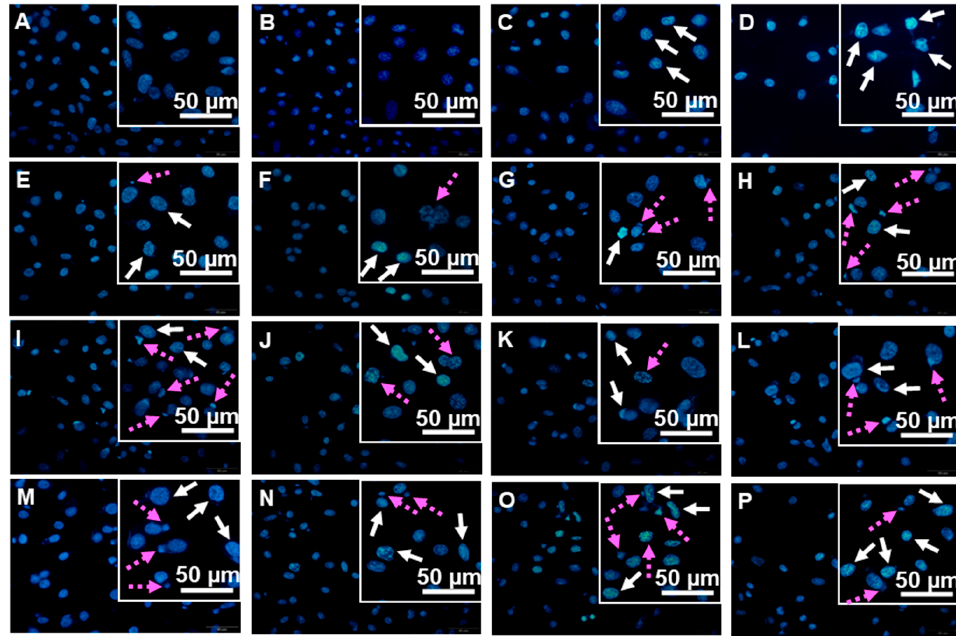
Figure 3. Hoechst 33342 nuclear staining on PC3 cancer cells after an exposure to compounds 1 – 6 (condensed DNA, white solid arrows; fragmented DNA, pink dotted arrows); ( A ) untreated; ( B ) DMSO; ( C , D ) cisplatin (10 and 15 μ M); ( E , F ) 1 (5 and 10 μ M); ( G , H ) 2 (5 and 10 μ M); ( I , J ) 3 (5 and 10 μ M); ( K , L ) 4 (5 and 10 μ M); ( M , N ) 5 (5 and 10 μ M); and ( O , P ) 6 (5 and 10 μ M), respectively.